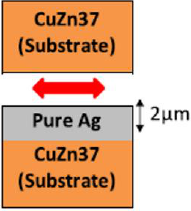
Figure 7. Interface configuration of inhomogeneous contact.